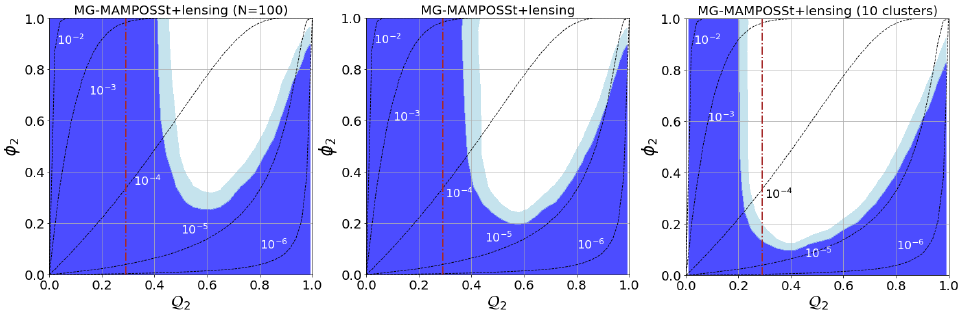
Figure 2. Results for the joint lensing and internal kinematics analysis of the synthetic haloes in our sample. The shaded areas show the allowed regions in the plane ( Q 2 , φ 2 ) at 3 σ (outer region) and 2 σ (innermost region). ( Left panel ): 100 tracers in the MG-MAMPOSS T fit. ( Central panel ): 600 tracers in the MG-MAMPOSS T fit. ( Right panel ): combination of 10 clusters, 600 tracers considered in each halo. The black dashed curves are lines of constant φ / Q while the vertical brown dash-dotted lines √ indicate value of the coupling Q = 1/ 6 corresponding to f ( R ) gravity. From